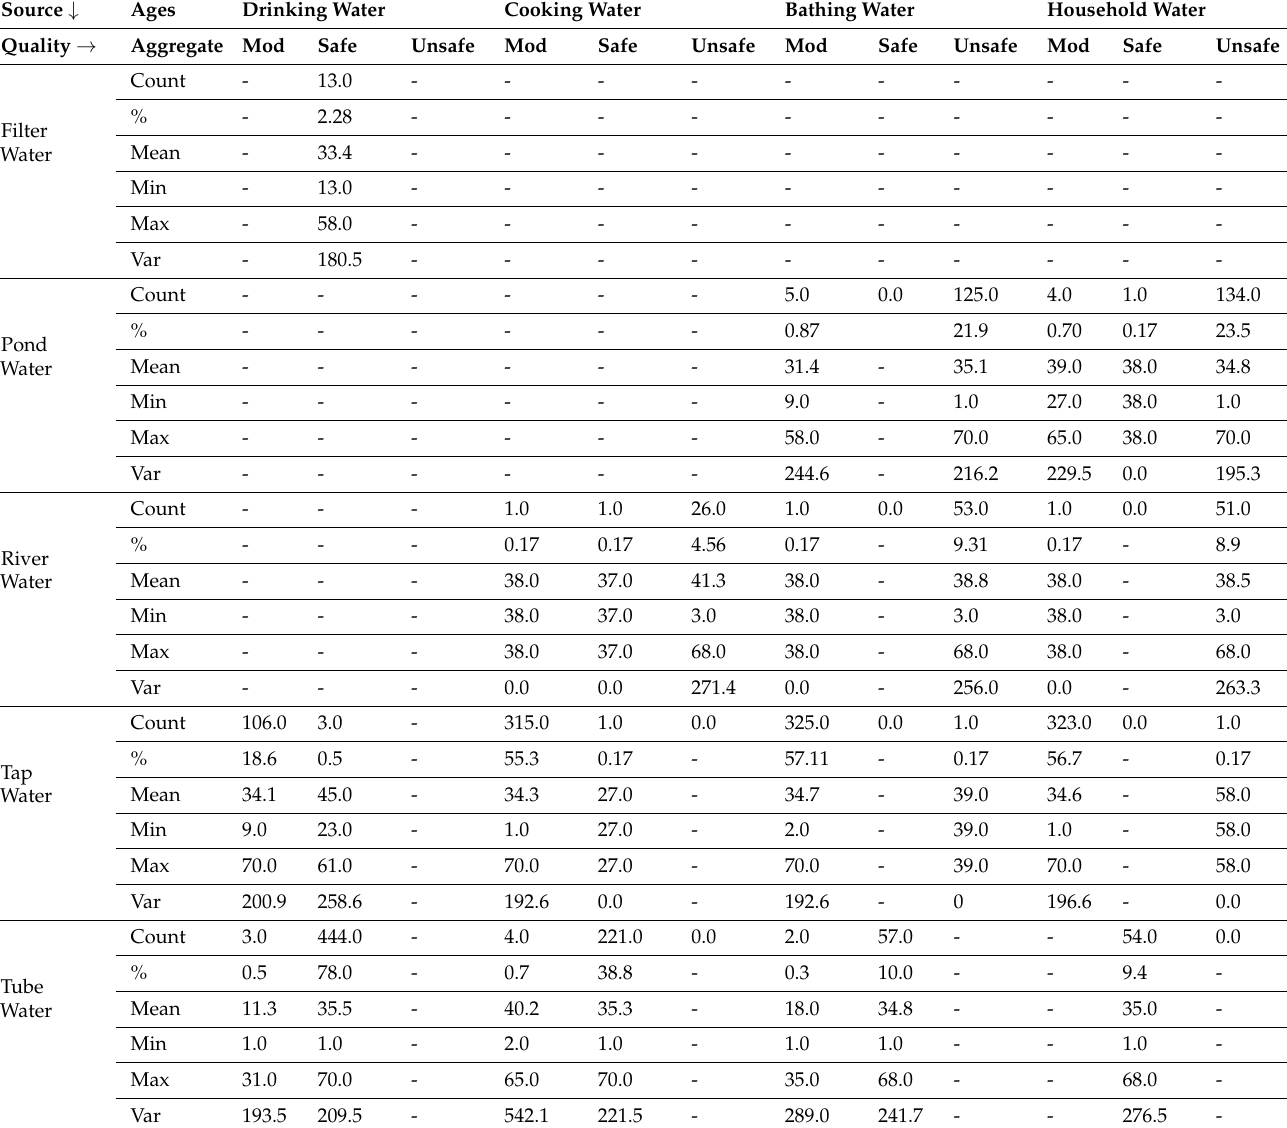
Table 7. Data classification on the consumption of different water sources and water